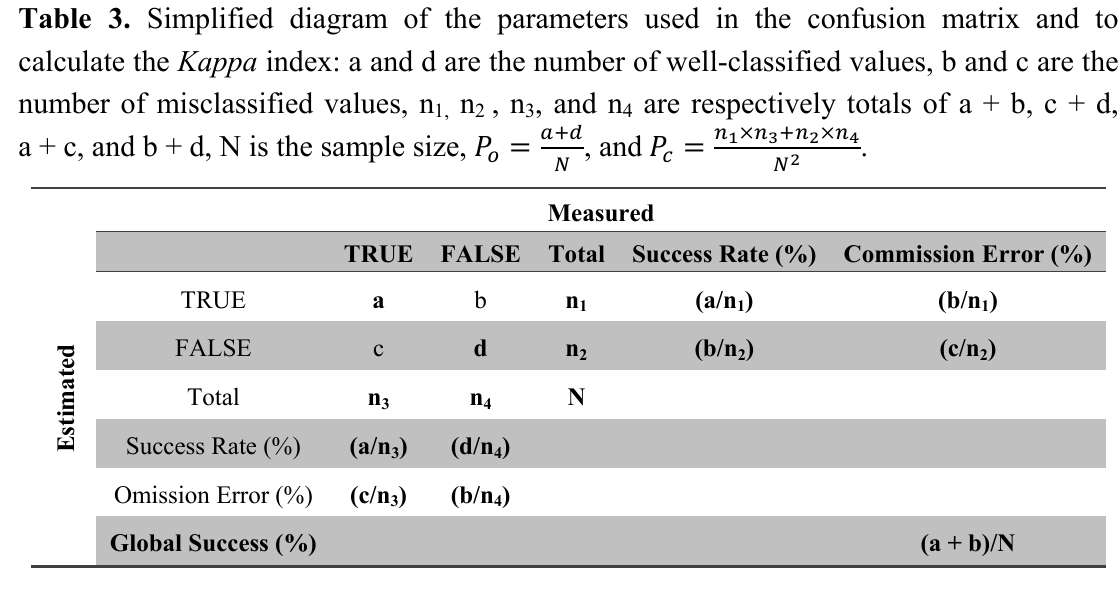
n , n , and n are respectively totals of a + b, c + d, 1, 2 3 4 (cid:3028)(cid:2878)(cid:3031) (cid:3041) (cid:3117) ×(cid:3041) (cid:3119) (cid:2878)(cid:3041) (cid:3118) ×(cid:3041) (cid:3120) , and (cid:1842) = = (cid:3042) (cid:3030) (cid:3015) (cid:3015)